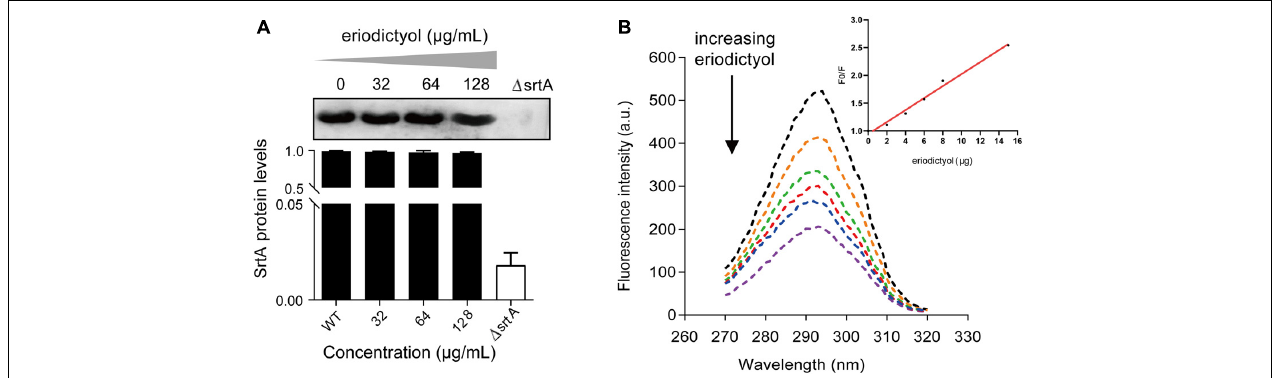
FIGURE 4 | The expression level of SrtA and the interaction between eriodictyol and StrA measured by the fluorescence quenching assay. (A) Western blot analysis of SrtA from S. aureus treated with various concentrations of eriodictyol and grayscale analysis of the SrtA protein bands. (B) Fluorescence quenching assays were performed to evaluate the binding affinity of eriodictyol to